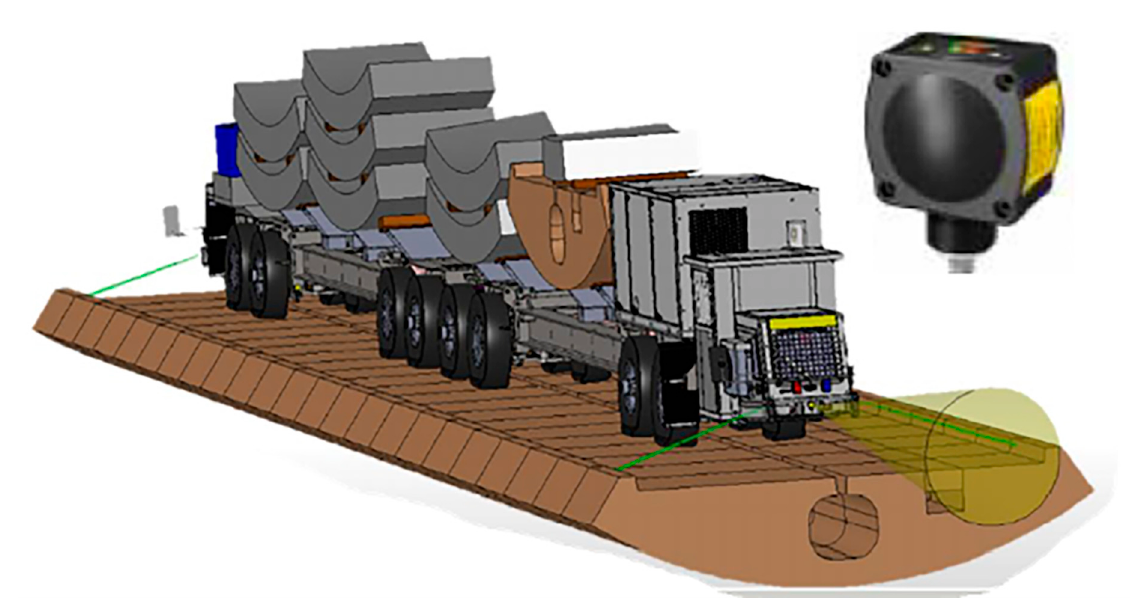
Figure 7. Radar positioned in front of the vehicle’s cockpit; detection distance of 24 m.